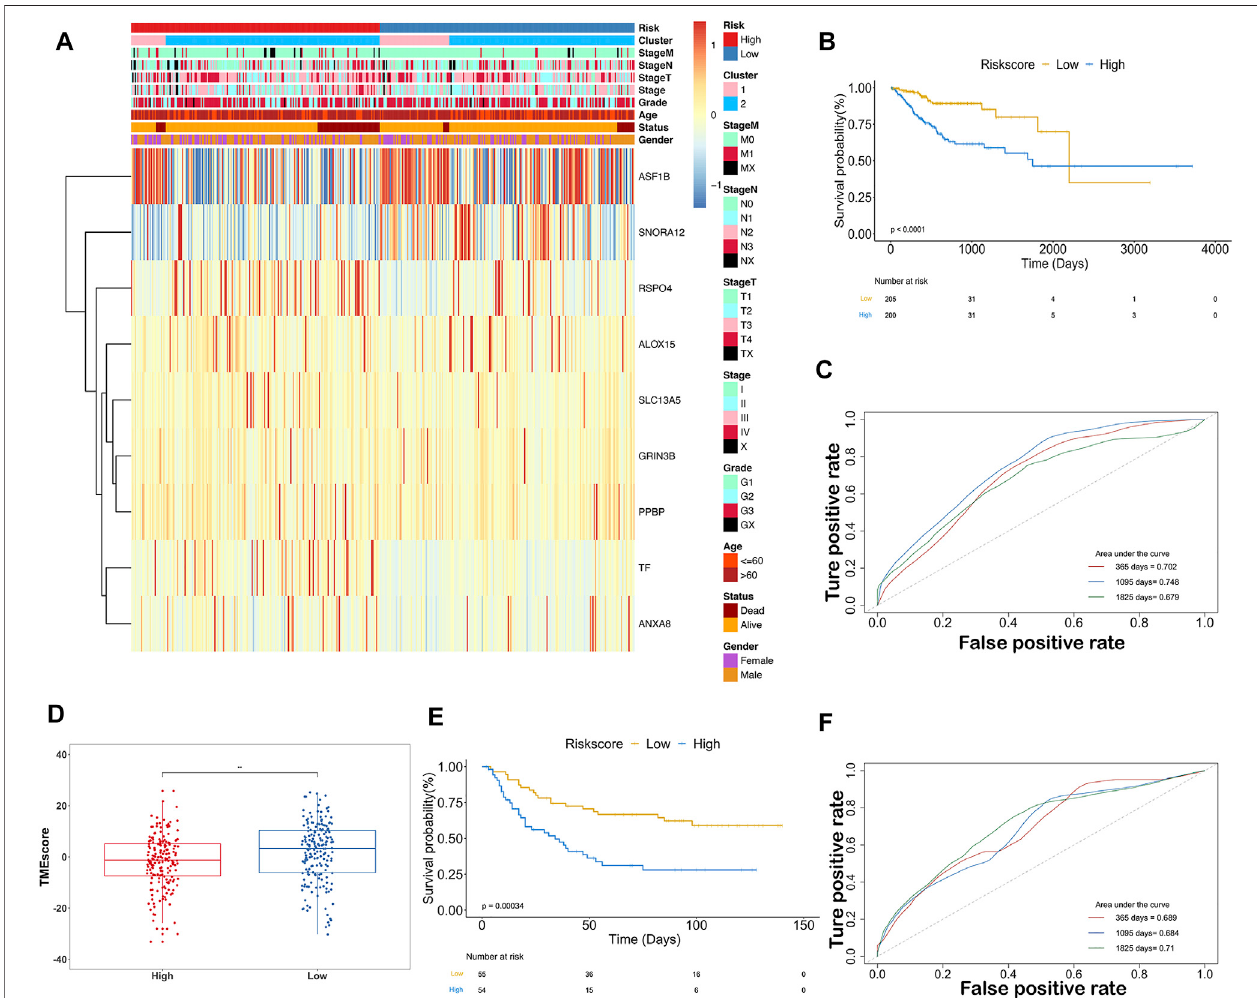
FIGURE 8 | Predictive ability of the ISR model in TCGA and GEO databases. (A) Expression of 9-gene and clinicopathological features in each patient (TCGA-STAD). Heatmapshowed9-geneexpressionpro fi lesinhigh-IRSandlow-IRSgroups,basedonthemedianvalue.Sampleannotationsshowtheclinicopathologicalcharacteristicsand clusters. (B) KMplotsshowedtheOSinthetraininggroupwithhighIRSandlowIRS( p < 0.0001). (C) PrognosticvaluesofIRSinthetraininggroupin1-,3-,and5-yearOSwith AUC = 0.702, 0.748, and 0.679, respectively. (D) Box plots showed the difference of TMEscore between high IRS and low IRS. (E) KM plots showed the OS in the validation group with high IRS and low IRS ( p < 0.001). (F) Prognostic values of IRS in the validation group in 1-, 3-, and 5-year OS with AUC = 0.689, 0.684, and 0.71,